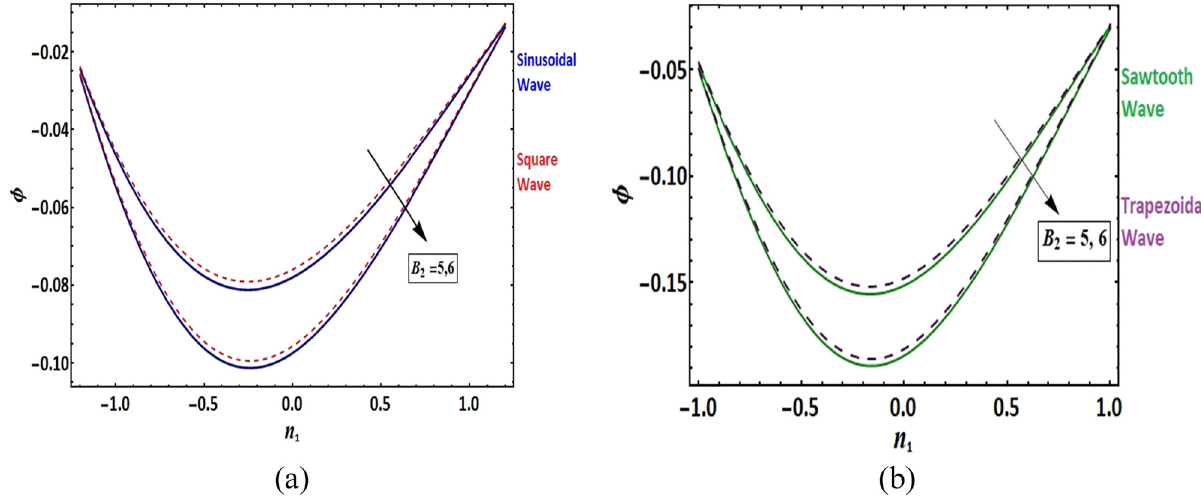
= 0.1, A = 2,Sr = 0.5, A = 1,Br = 0.5, K = 2,Sc = 0.5, ϵ 0.2 = , Gr 0.4 = , K = 3,and B 4 1 3 3 1